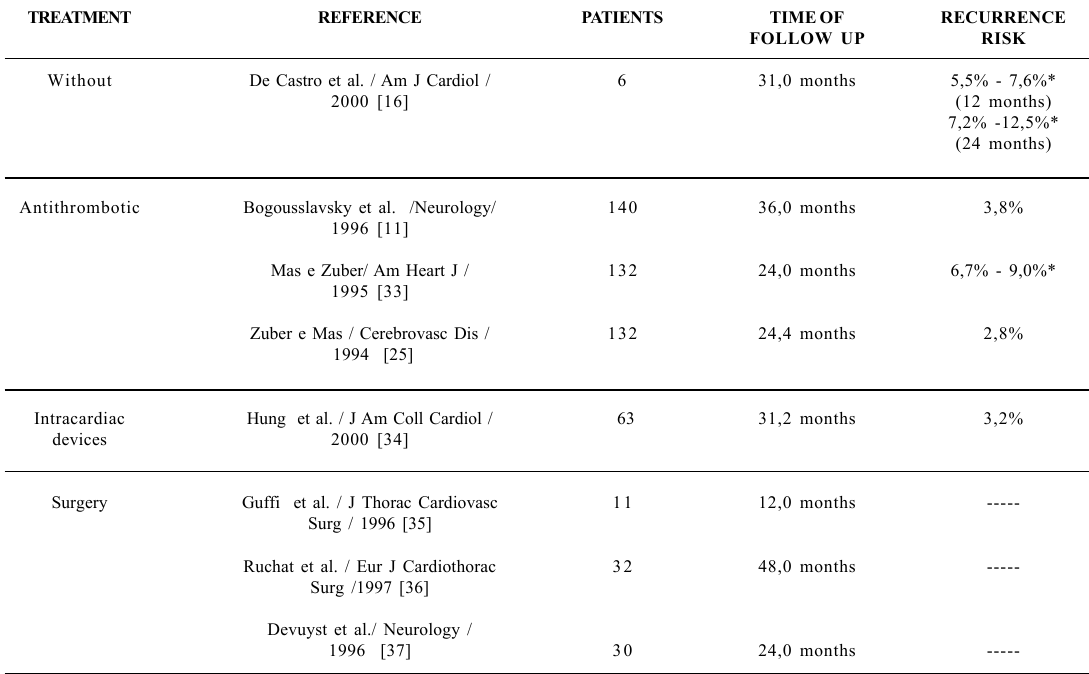
Table 3. Recurrence risk of stroke or transitory ischemic attacks in patients with patent foramen ovale and proved cerebral ischemia according to the type of treatment.